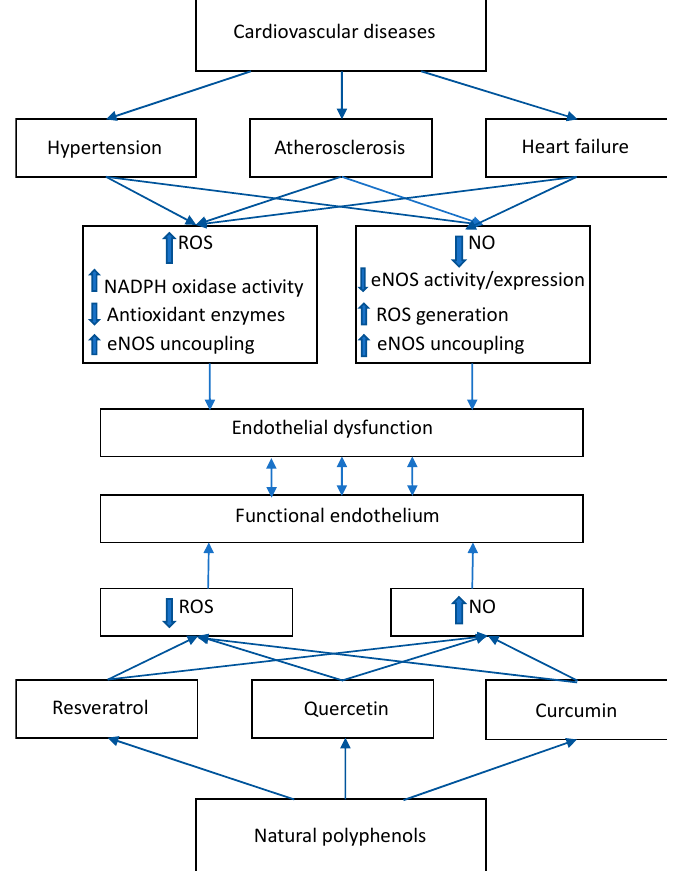
Figure 1. Cardiovascular diseases, including hypertension, atherosclerosis, and heart failure are accompanied by increased production of reactive oxygen species (ROS), also via enhanced nicotinamide adenine dinucleotide phosphate (NADPH) oxidase activity, with subsequent decreased nitric oxide (NO) generation, leading to endothelial dysfunction. Many natural polyphenols like resveratrol, quercetin, or curcumin are able to fight endothelial dysfunction by their ability to decrease ROS generation, induce the endogenous antioxidant enzymatic defense system, and increase activity / expression of endothelial NO synthase